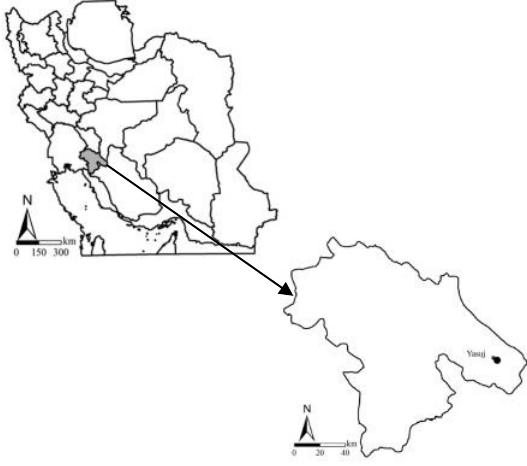
Figure 1: The study area in Kohgiluye-va-BoyerAhmad province and Iran.